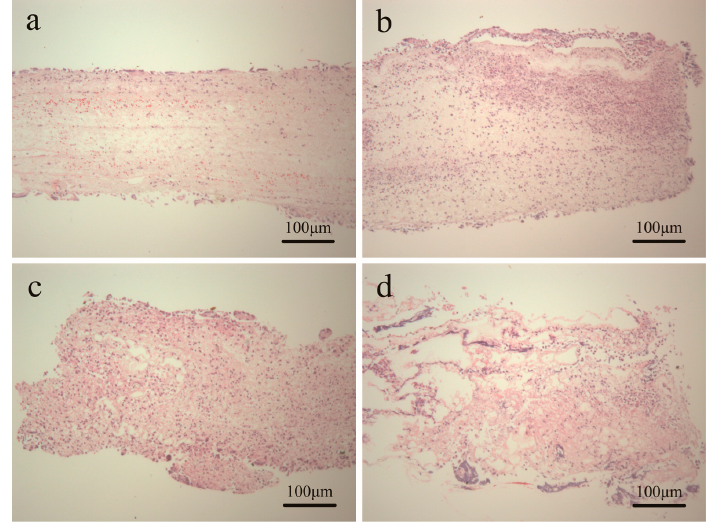
Figure 7. H and E images of subcutaneous implanted scaffolds for seven days: ( a ) PLGA; ( b ) P(LA- co -GA- co -MMD) 1 ; ( c ) P(LA- co -GA- co -MMD) 2 ; and ( d ) P(LA- co -GA- co -MMD) 3 .